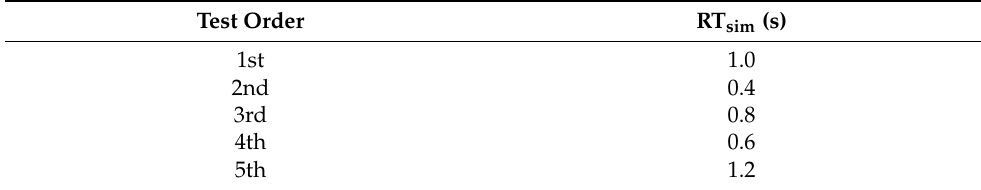
Table 10. Experiment output order.